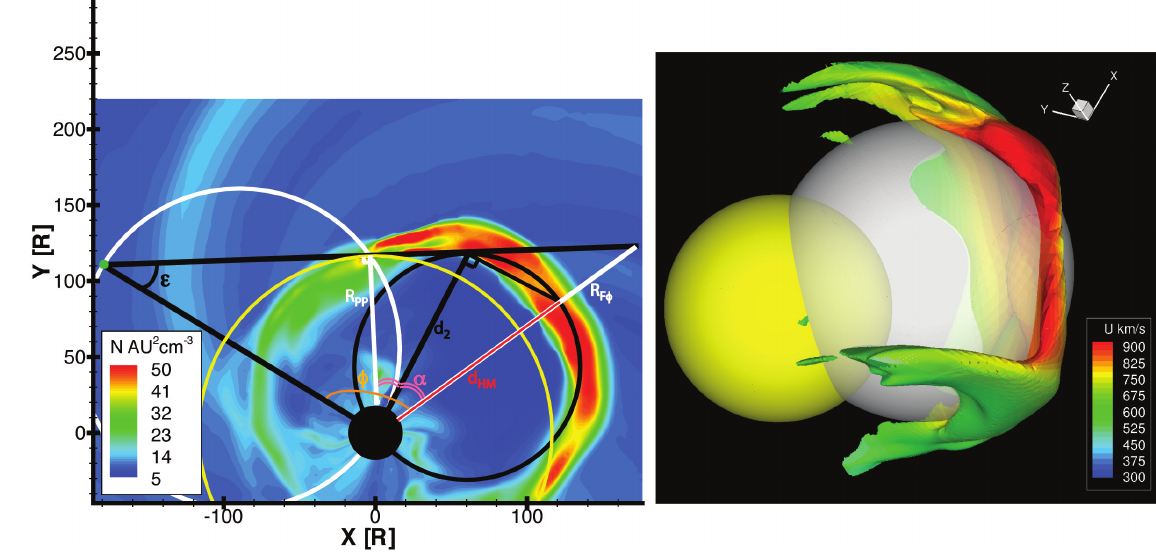
Fig. 1. Left: Geometry of the observations and the methods described in the article. The figure corresponds to the 24–25 January CMEs in the late phase of their merging. This illustrates the different CME positions obtained from one measurement of the elongation angle at (cid:15) . The black and yellow circles illustrate the model of CMEs used to derive the relation described in the article and the Point-P approximation, respectively; the white circle is the Thomson sphere; the green dot and black disk are STEREO-A and the Sun, respectively (not to scale). The angle φ is set at 90 ◦ to determine the CME distances but it is shown here as determined from the position of the active region at the start of the eruptions. Right: The model (expanding propagating sphere) proposed to derive CME positions from SECCHI measurements is illustrated for a different simulation (24 August 2002) with different models of the solar wind and CME initiation. The yellow sphere is centered at the Sun, the white translucent sphere is the model of the CME front and the actual simulated CME is shown as an isosurface of scaled density 20cm − 3 AU − 2 color-coded with the